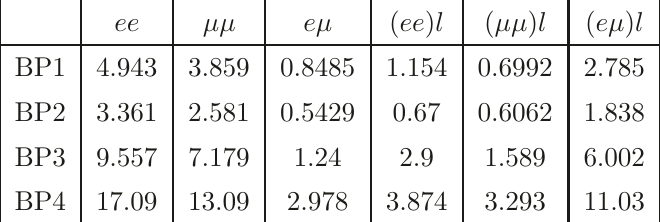
Table 6. Flavour composition of 2- and 3-displaced leptons in the tracker.